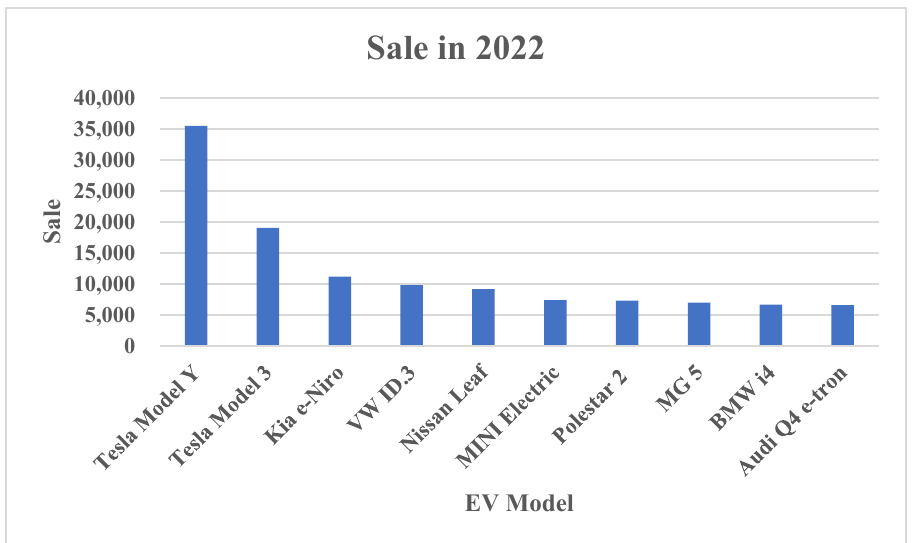
Figure 3. Sale of different EV models in 2022 [38].